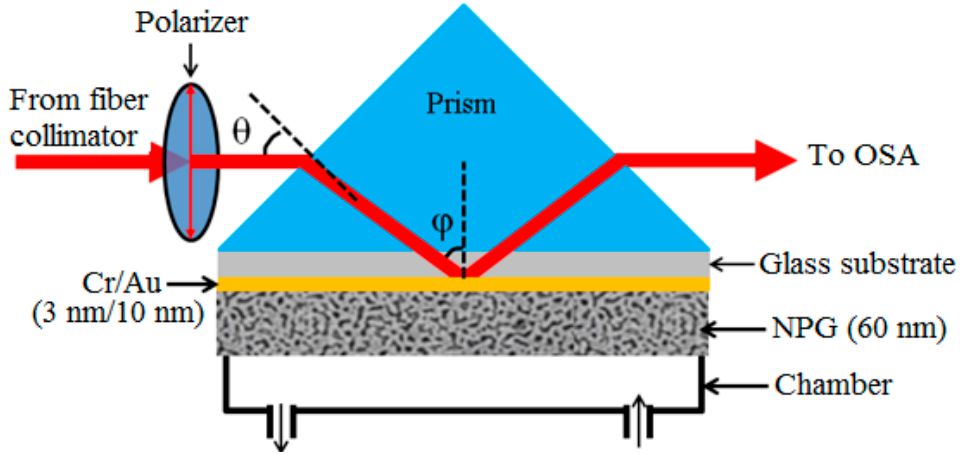
Figure 1. Schematic diagram of the NPG-film-based wavelength-interrogated SPR sensor platform used in this work.